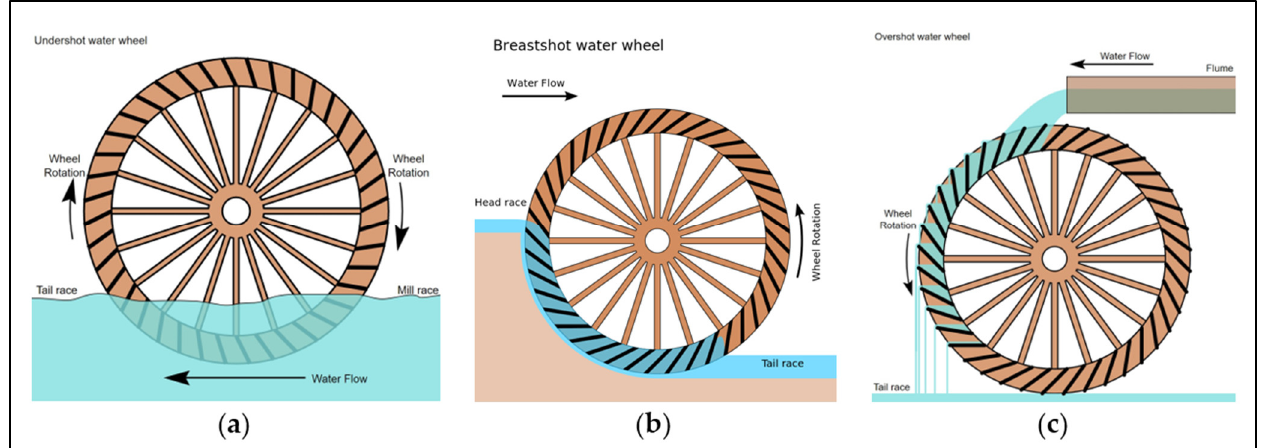
Figure 3. Water mills powered by vertical-water wheels could be further divided into: ( a ) undershot, ( b ) breastshot, and ( c ) overshot, depending on the arrangement of water flow [2]. Water mills are known to have appeared at roughly around the same time in several different regions. The horizontal mill appeared almost simultaneously in the Middle East, Mediterranean Basin, and China between 100 BC and 100 AD. The vertical mill also appeared at roughly around the same time in the Middle East, Mediterranean Basin, and China [5]. When and where the water wheel originated remains unclear, with various hypotheses regarding its origins.